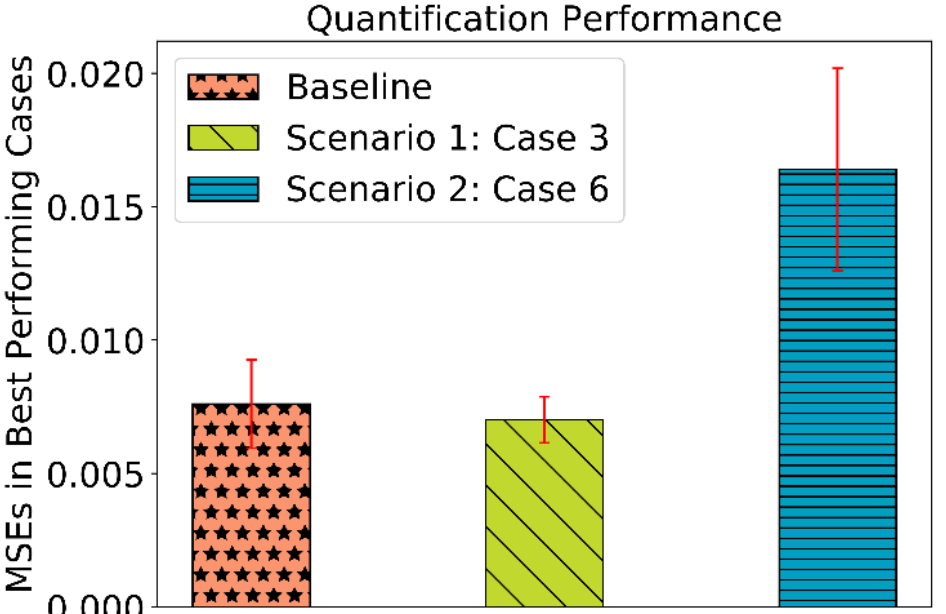
Figure 7. MSEs in quantification performance obtained in baseline and best performing cases in both the scenarios, viz., scenario 1: case 3 and scenario 2: case the scenarios, viz., scenario 1: case 3 and scenario 2: case 6.